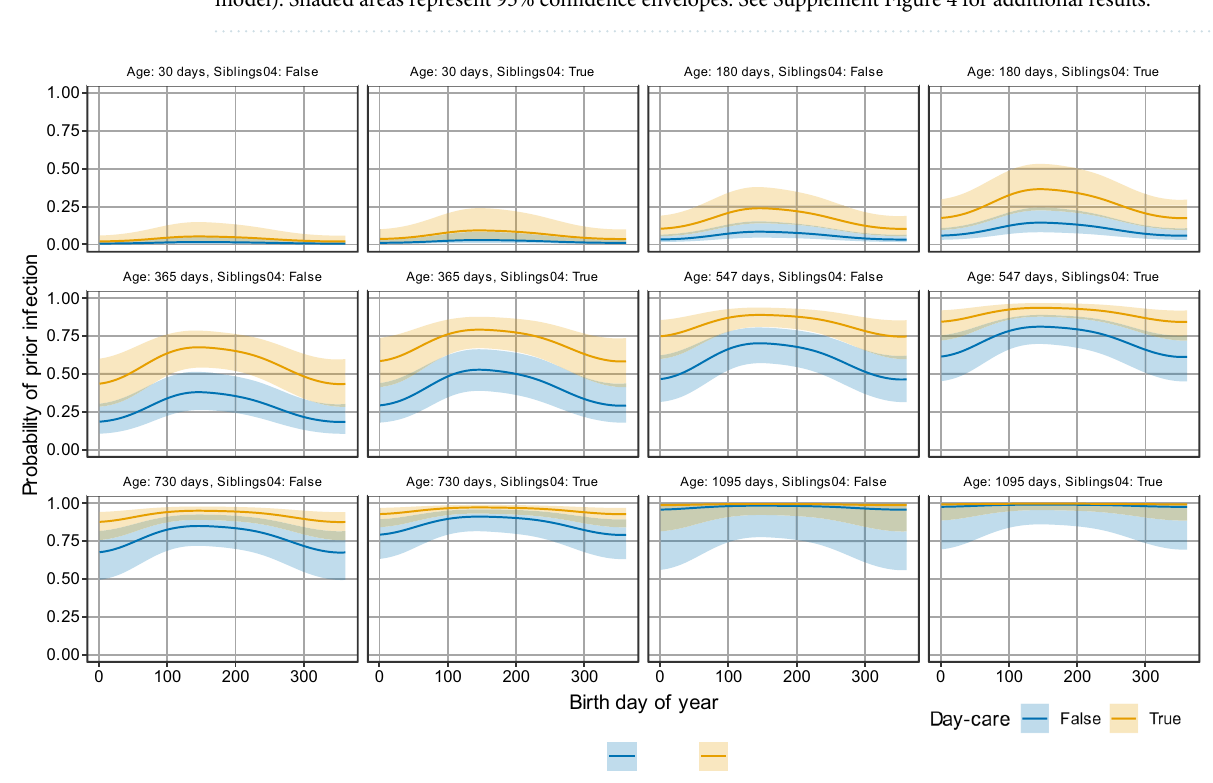
Figure 4. Estimates of the probability of prior infection as function of age, birth DOY, and risk factors. Shown is the estimated probability of prior infection as function of birth DOY within the year for various ages and for living with or without a young sibling (siblings0–4). Colours indicate visiting a day-care and shaded areas represent 95% confidence